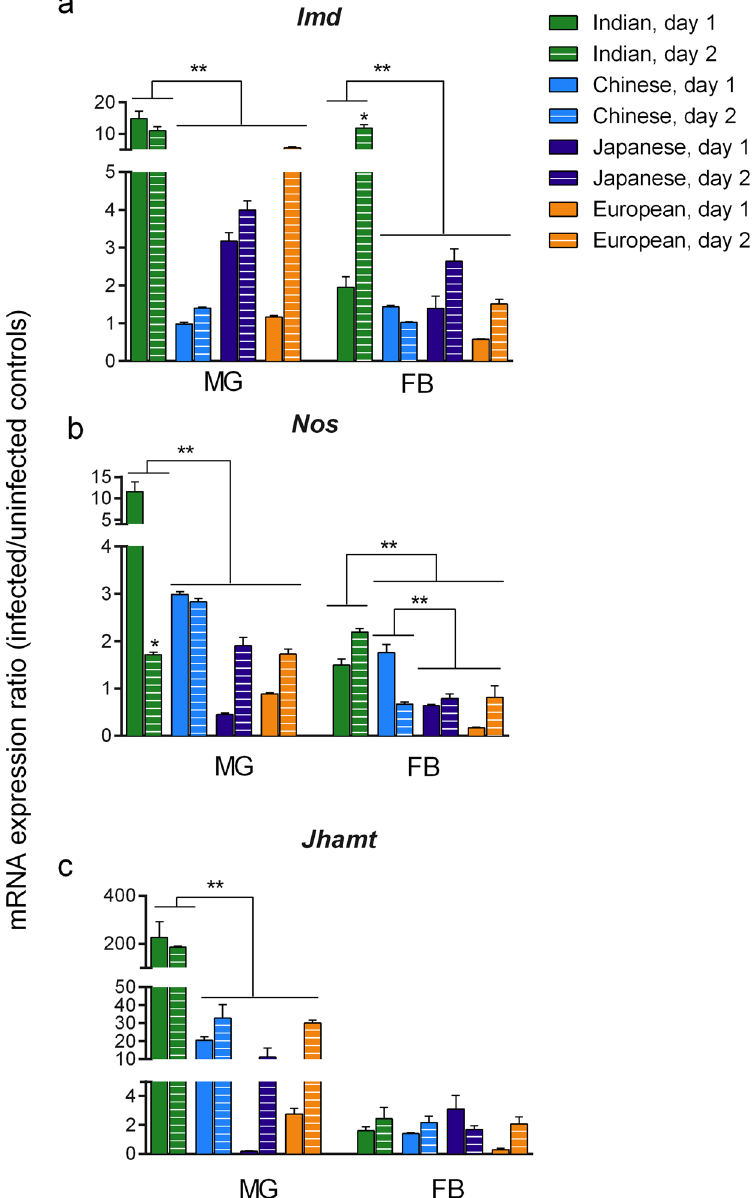
Figure 5. Local and systemic expression of Imd , Nos and Jhamt after S . marcescens infection. The mRNA expression of Imd ( a ), Nos ( b ) and Jhamt ( c ) in the midgut (MG) and fat bodies (FB) of the four B . mori strains for two days after S . marcescens infection. Expression ratios represent the immune gene/ actin3 mRNA levels of infected samples over those of their relative uninfected controls (mean ± SEM, nine samples pooled in three replicates per time per condition). The Indian strain showed the highest expression values for all the three genes in the midgut (two-way ANOVA, effect of strain: p < 0.0001 for each of the three genes), and for Imd and Nos in the fat body (two-way ANOVA, effect of strain: p < 0.0001). ** Indicates significant differences in expression levels among the four strains (Bonferroni post - hoc test, p < 0.01); * indicates a significant intra-strain difference in the expression levels of the target gene between the first and second day (Bonferroni post - hoc test p < 0.05). (Statistical details in Supplementary Table